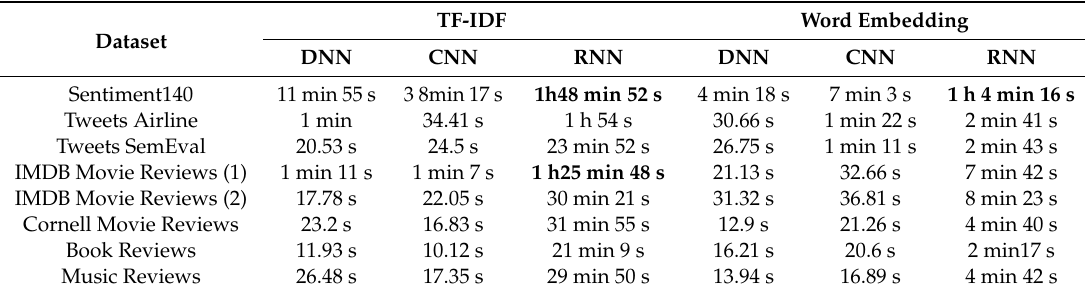
Table 8. CPU times of experiments with numbers of datasets with a